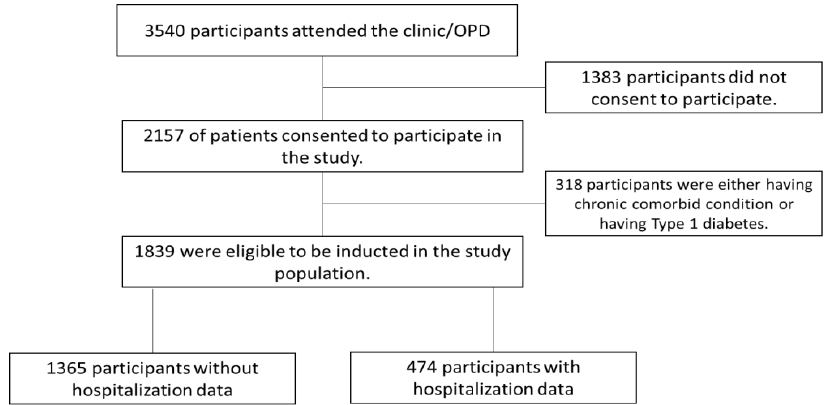
Figure 1. Schematic chart of diabetes participants recruitment in the study.